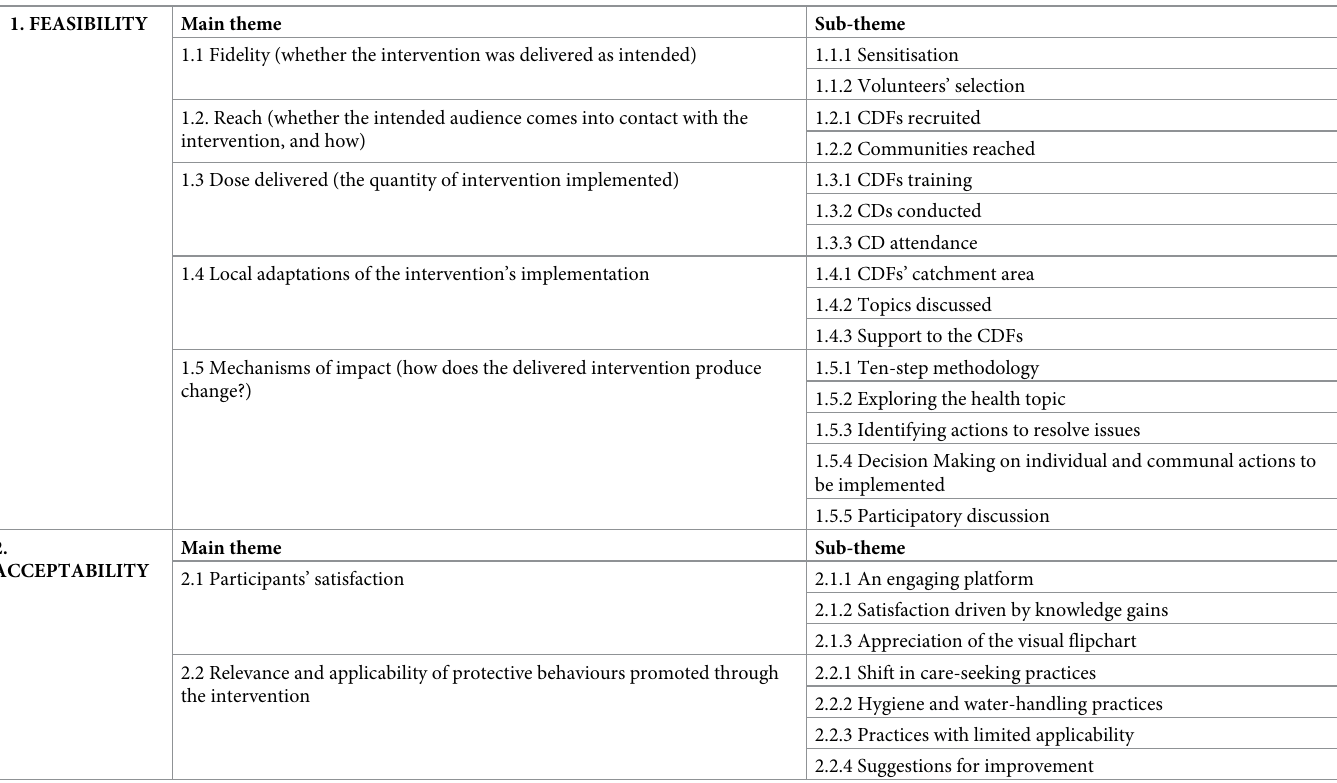
Table 3. Main themes and